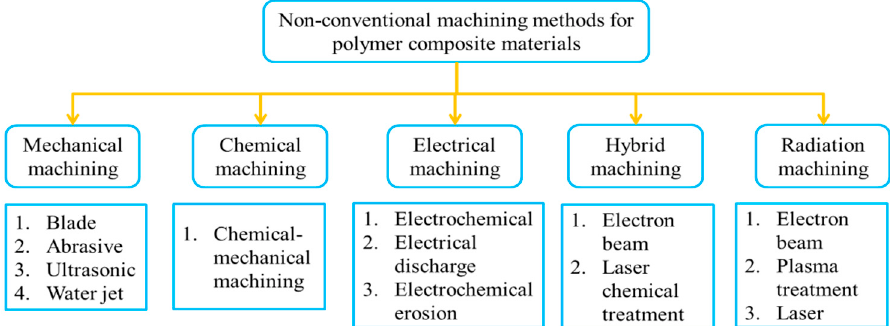
Figure 2. Non-conventional machining methods of polymer composite materials.